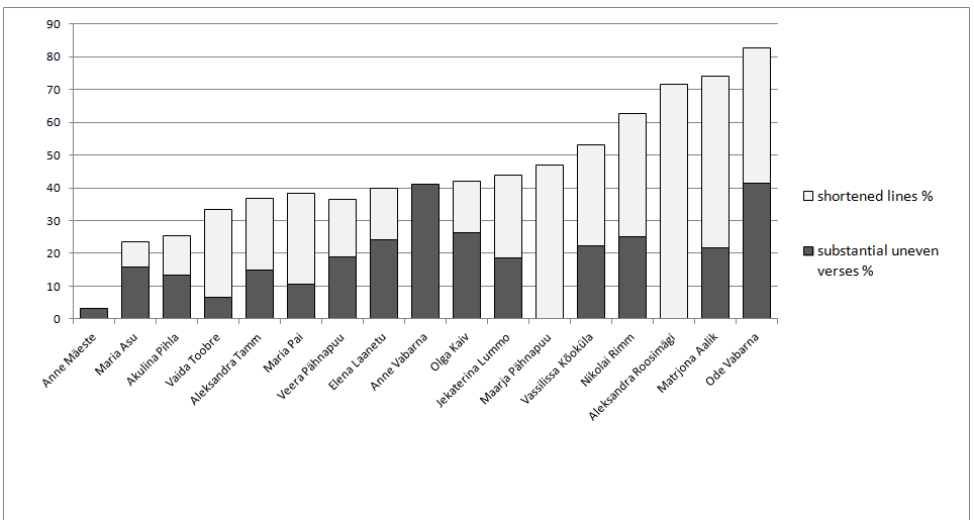
Figure 7: The percentage of substantial uneven verses and shortened lines among all performed song lines. Data of singers from whom at least 20 lines have been